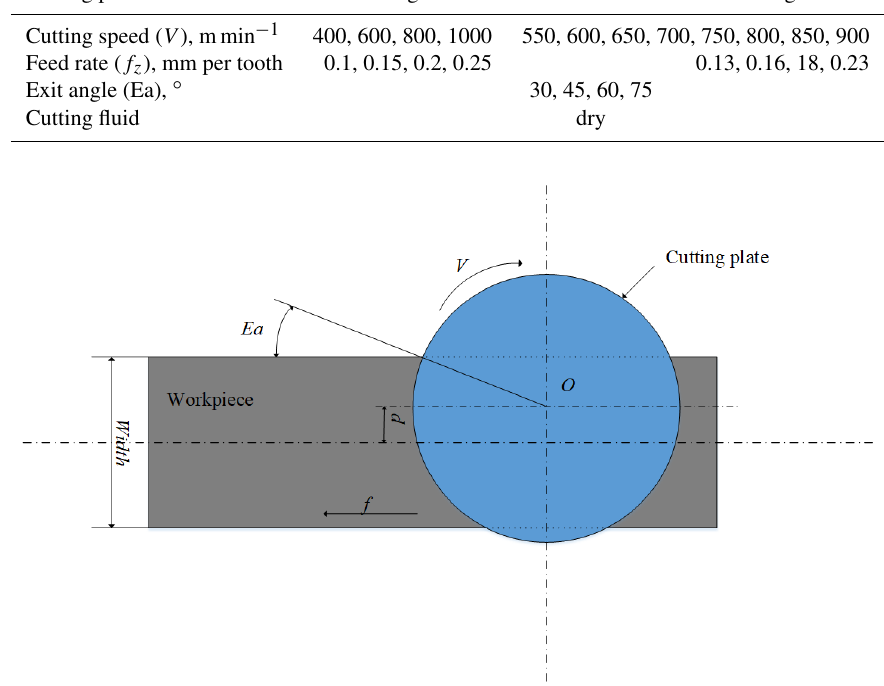
Figure 4. The distribution circumstance of the cutting speed, the feed rate and the exit angle in the process of milling